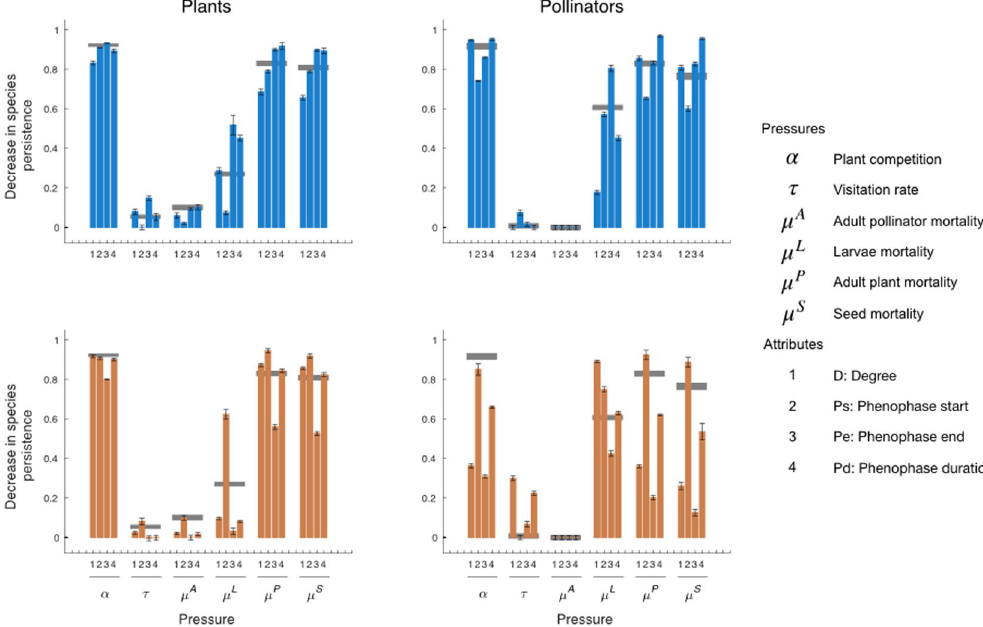
Figure 2. Simulation results for the Villavicencio (2011) plant–pollinator network (see Table 1). Left/right plots show decreases in plant/pollinator species persistence (mean ± 95% C.I.) after exerting different pressures, relative to species persistence without exerting any pressure (see text for details). Experimental pressures, applied one by one, were increased plant competition α , decreased visitation rate τ , and increased mortality of pollinators μ A , larvae μ L , adult plants μ P and seeds μ S . Pressure intensities were assigned to species according to their attributes: 1: degree; 2: phenophase start; 3: phenophase end; 4: phenophase duration. Results for pressures assigned at random are shown as gray horizontal bars, whose heights indicate the 95% C.I. Blue bars: simulations in which pressure magnitude increased with increasing attribute values (low to high D, earlier to later Ps or Pe, and small to large Pd); orange bars: simulations for which pressure magnitude increased with decreasing attribute values.